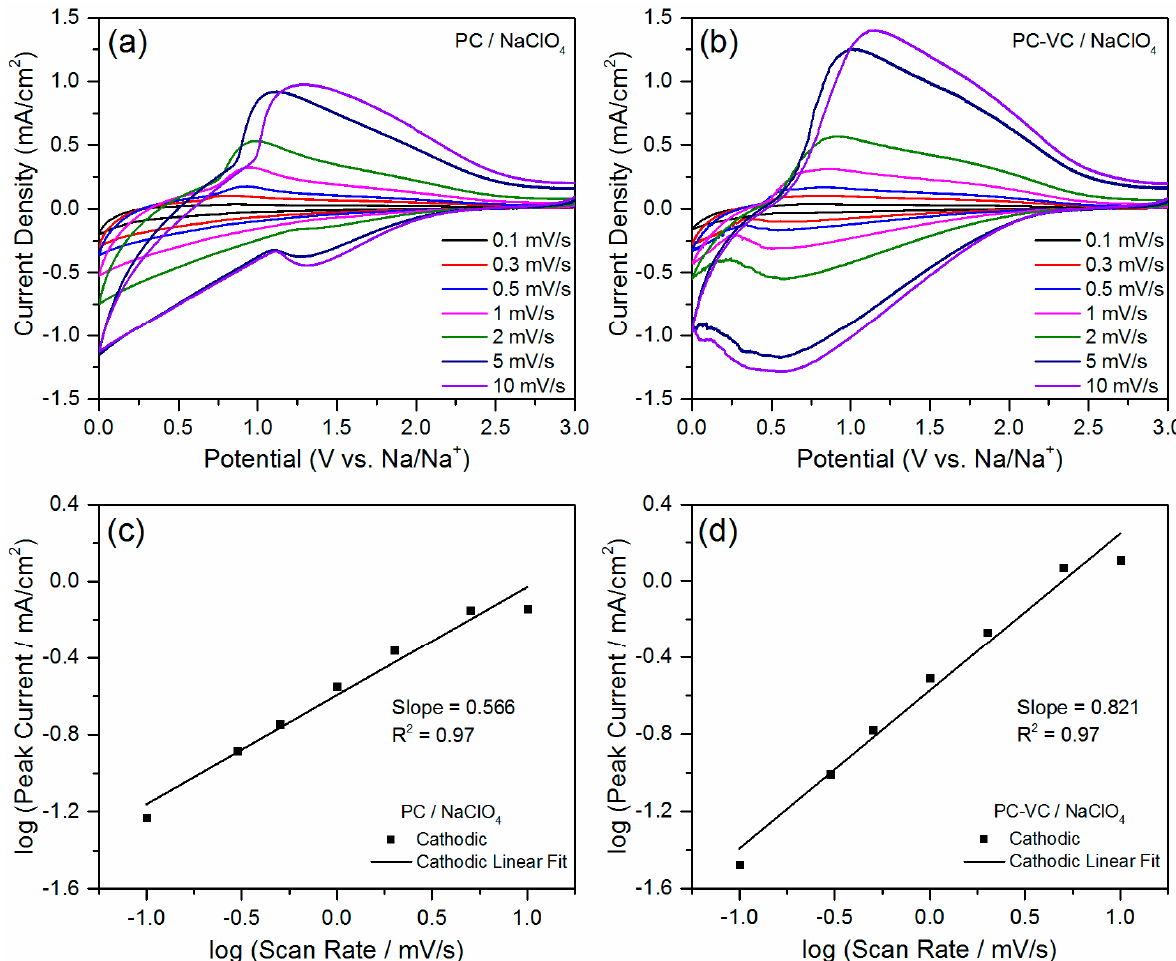
Figure 5. Cyclic voltammograms of TiO 2 nanosheet anodes at various scan rates in ( a ) PC / NaClO 4 and, ( b ) PC-VC / NaClO 4 electrolyte solutions. Scan rate dependence of peak current density for TiO 2 nanosheet anodes in ( c ) PC / NaClO 4 , and ( d ) PC-VC / NaClO 4 electrolyte solutions.